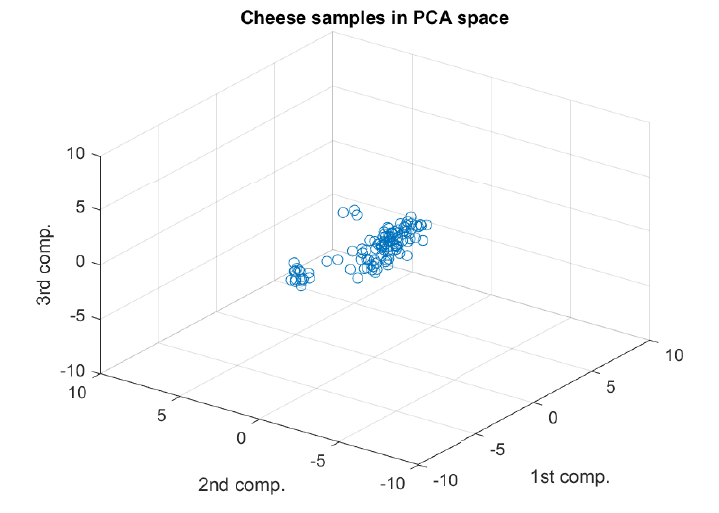
Figure 4. Scores plot—cheese spectral dataset represented in the Principal Components space. It can be observed that the main variability is found along the first PC. In the third direction the variation is quite